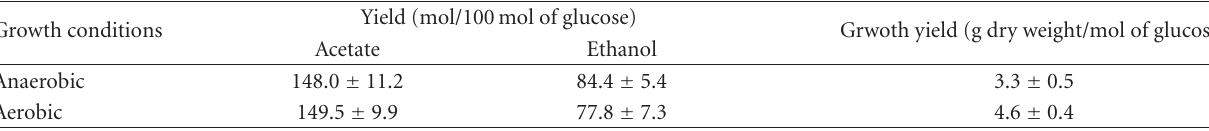
Table 2: Growth yield and yields of ethanol and acetate from growth of RB-1 a